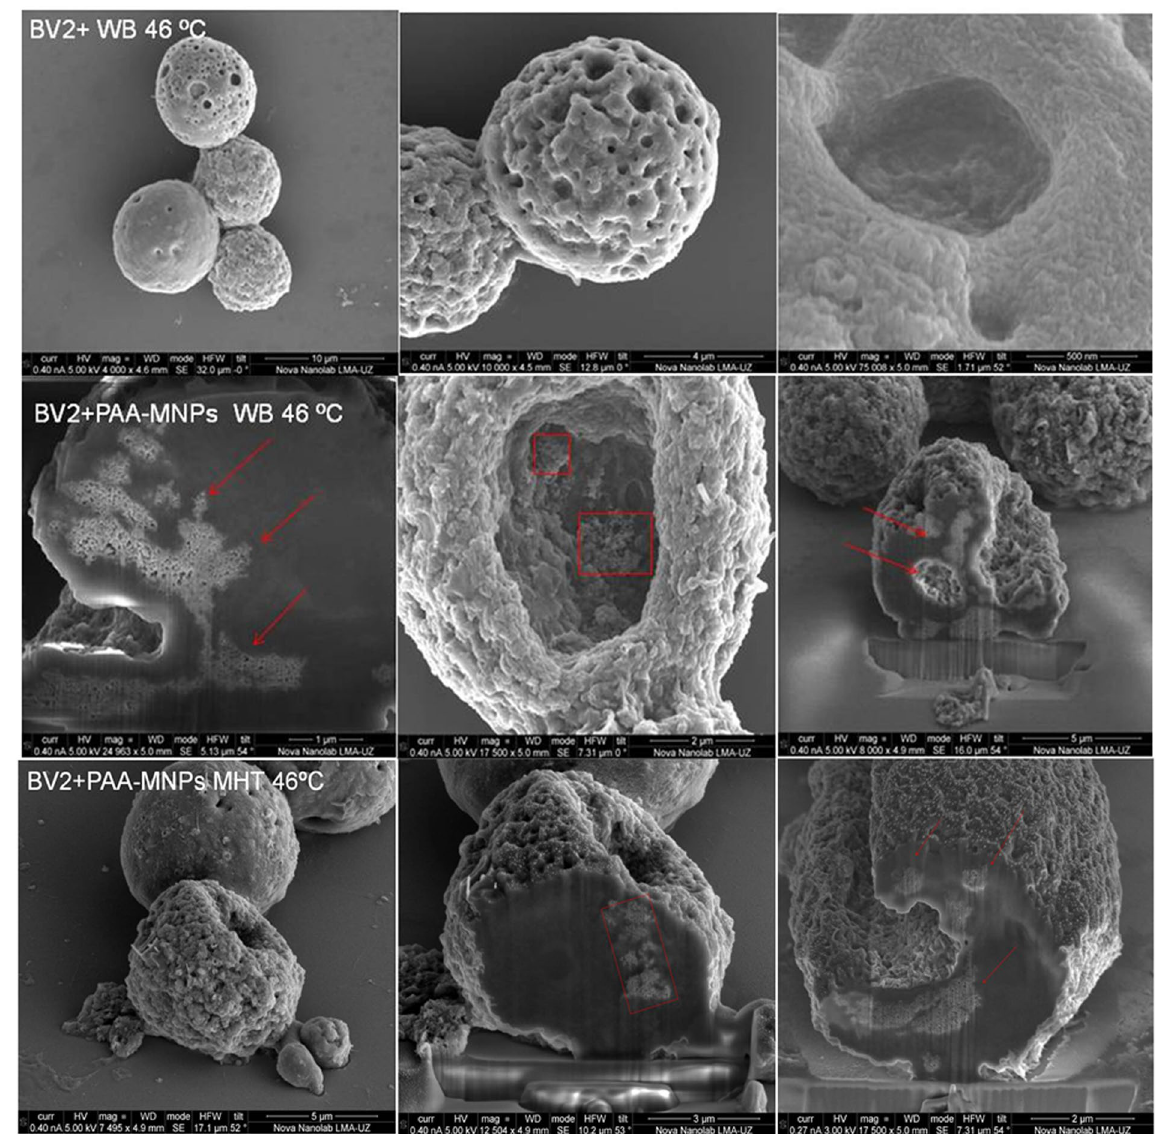
Figure 10. Scanning electron microscopic (SEM) images of BV2 cells after 30 min of water bath hyperthermia at 46 °C. SEM-FIB (Dual-Beam) images of BV2 cells containing 100 μ g/ml of PAA-MNPs after 30 min of water bath hyperthermia at 46 °C. Dual Beam images of BV2 + PAA − MNPs + AMF, final Tª = 46 °C; (100 μ g/ml PAA-MNPs, 24 k/m, f = 560 kA/m kHz and 30